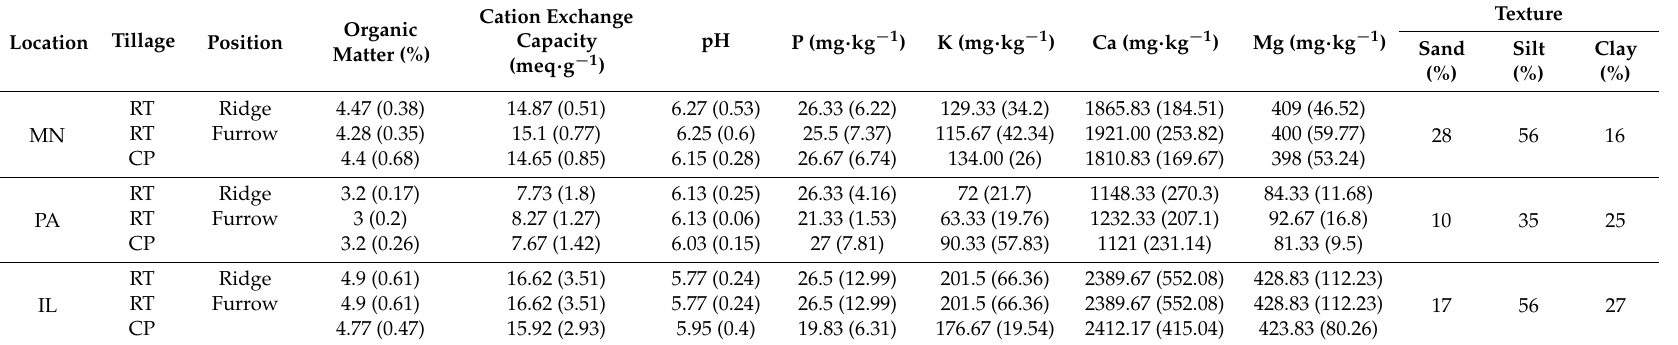
Table 1. Physical and chemical properties of Minnesota (MN), Pennsylvania (PA), and Illinois (IL) soils under ridge till (RT) and chisel plow (CP) management.